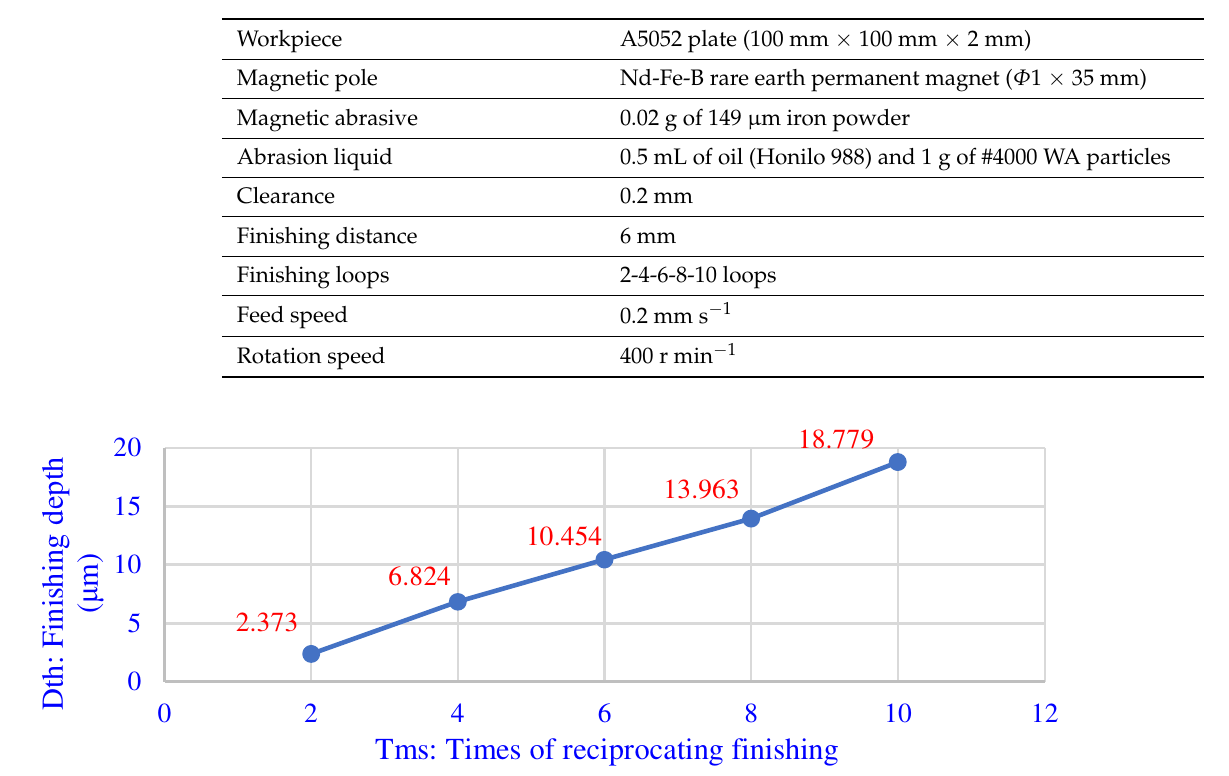
12 of 18 Figure 11. Evaluation of finishing efficiency. Table 1. Experimental conditions of evaluating finishing efficiency.